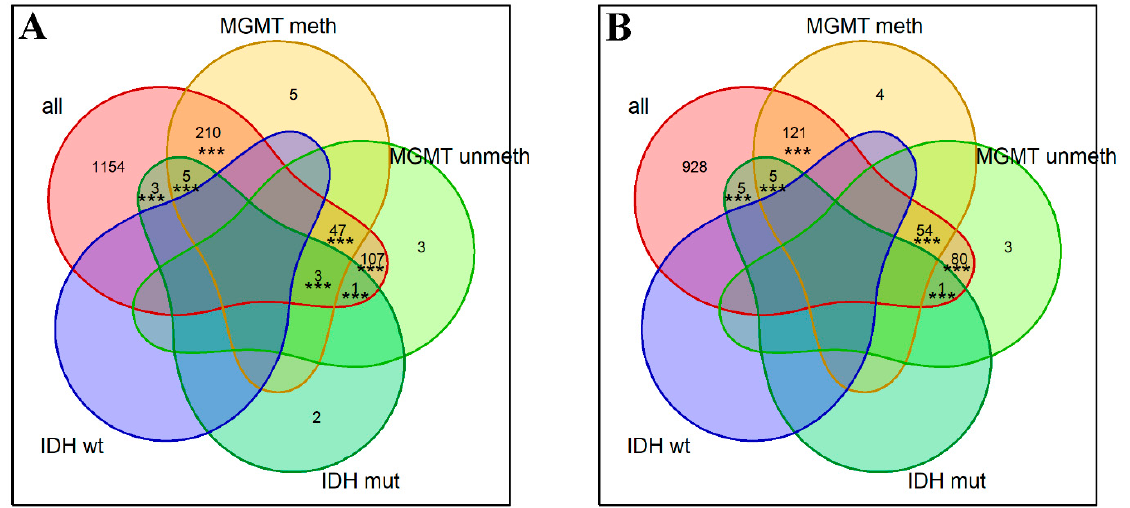
Figure 3. Numbers of gene expression biomarkers significantly associated with ( A ) shorter OS or ( B ) longer OS in the different LGG groups. Asterisks show significance levels of permutation testing for the respective intersections: *** for p < 0.001.